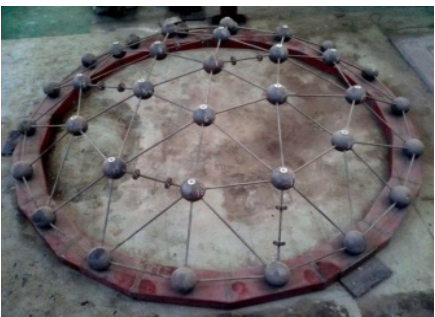
Figure 3. Photo of test model of the K6 single-layer spherical shell.